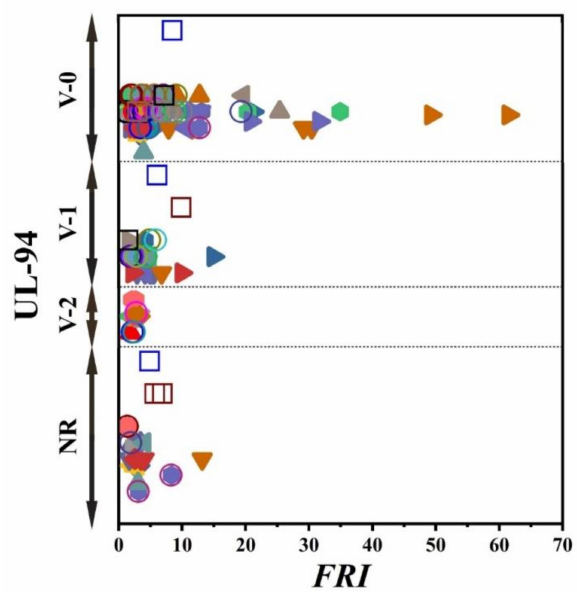
Figure 16. FRI values versus UL-94 test results. Symbols are indicative of combination of flame retardant (FR) additives used in PP. The vertical intervals in each category, i.e., V-0, V-1, V-2, and NR, are schematically representative of the amount of additive used. For example, two data distinguished by di ff erent symbols having the same or very close FRI values (horizontal quantity) in a given category (e.g., V-1), may have di ff erent vertical quantities, e.g., both reveal V-1 behavior in UL-94 test, but the upper contains more FR in